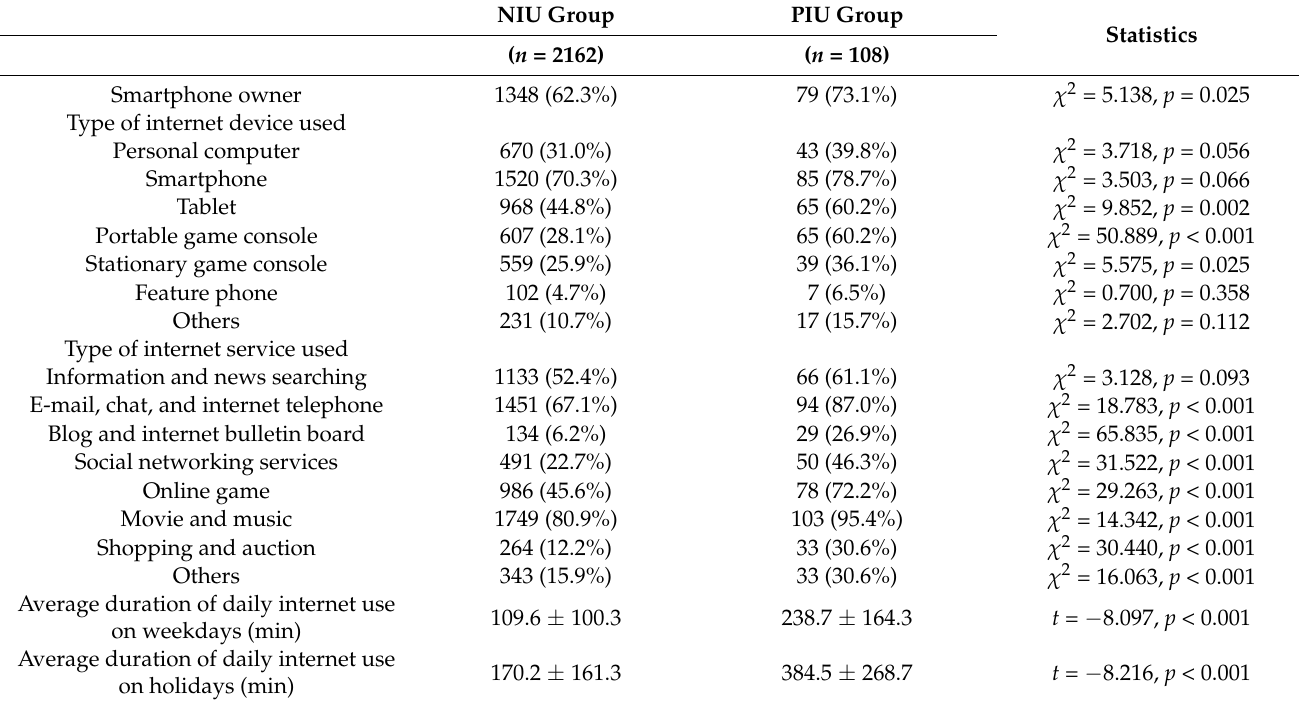
Table 4. Comparisons of smartphone ownership, type of internet device used, type of internet service used, and average duration of daily internet use between the study groups.